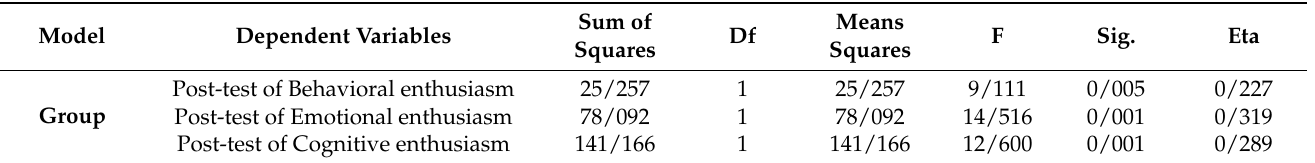
Table 6. Intergroup effects of academic enthusiasm components considering the experimental and control groups as an independent variable.